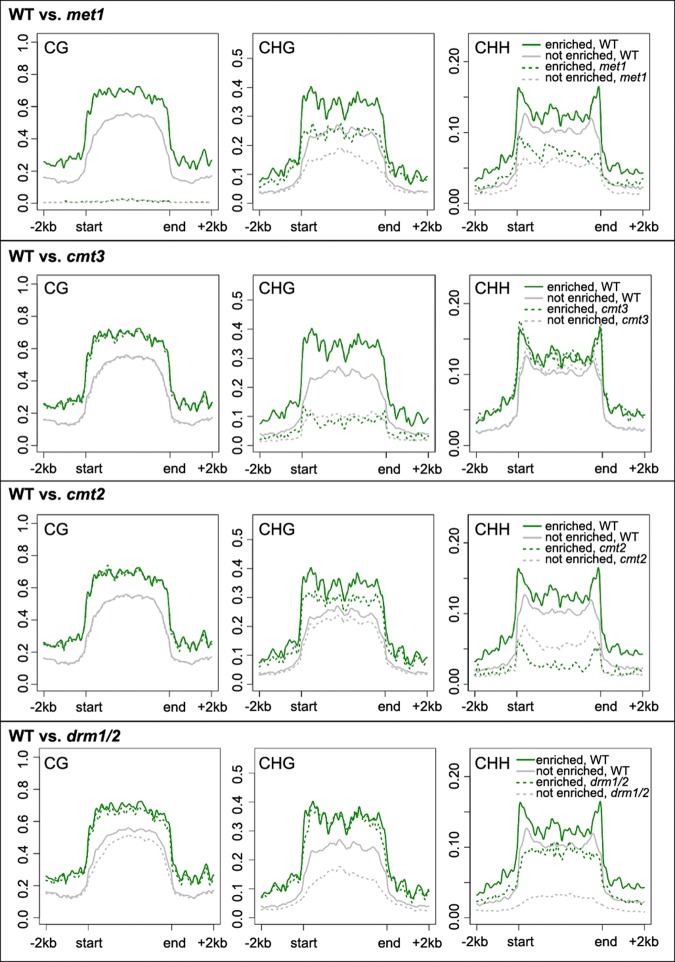
Comparison of DNA methylation over TEs. Patterns of TE DNA methylation (CpG, CHG, CHH) in wild-type (WT) and mutants. The grouping of TEs is according to the enrichment results of NUP1:GFP RE-ChIP-seq from 30-d-old leaf tissues. The methylation ratio is calculated in 100-bp windows. The signal over each TE is linearly transformed so that the boundaries of all TEs are aligned.